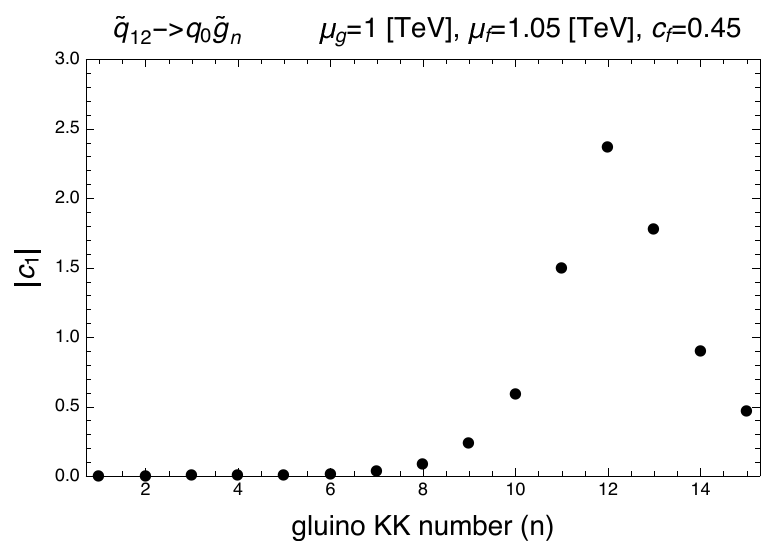
Figure 8. The coupling (3.6) between the 12th KK squark, zero mode quark, and KK gluino, with z IR = 0 : 1GeV (cid:0) 1